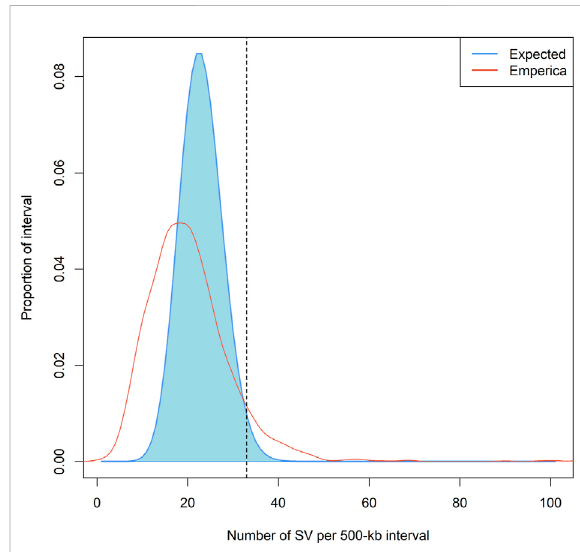
FIGURE 4 Non-random distribution of SVs across chicken genomes.